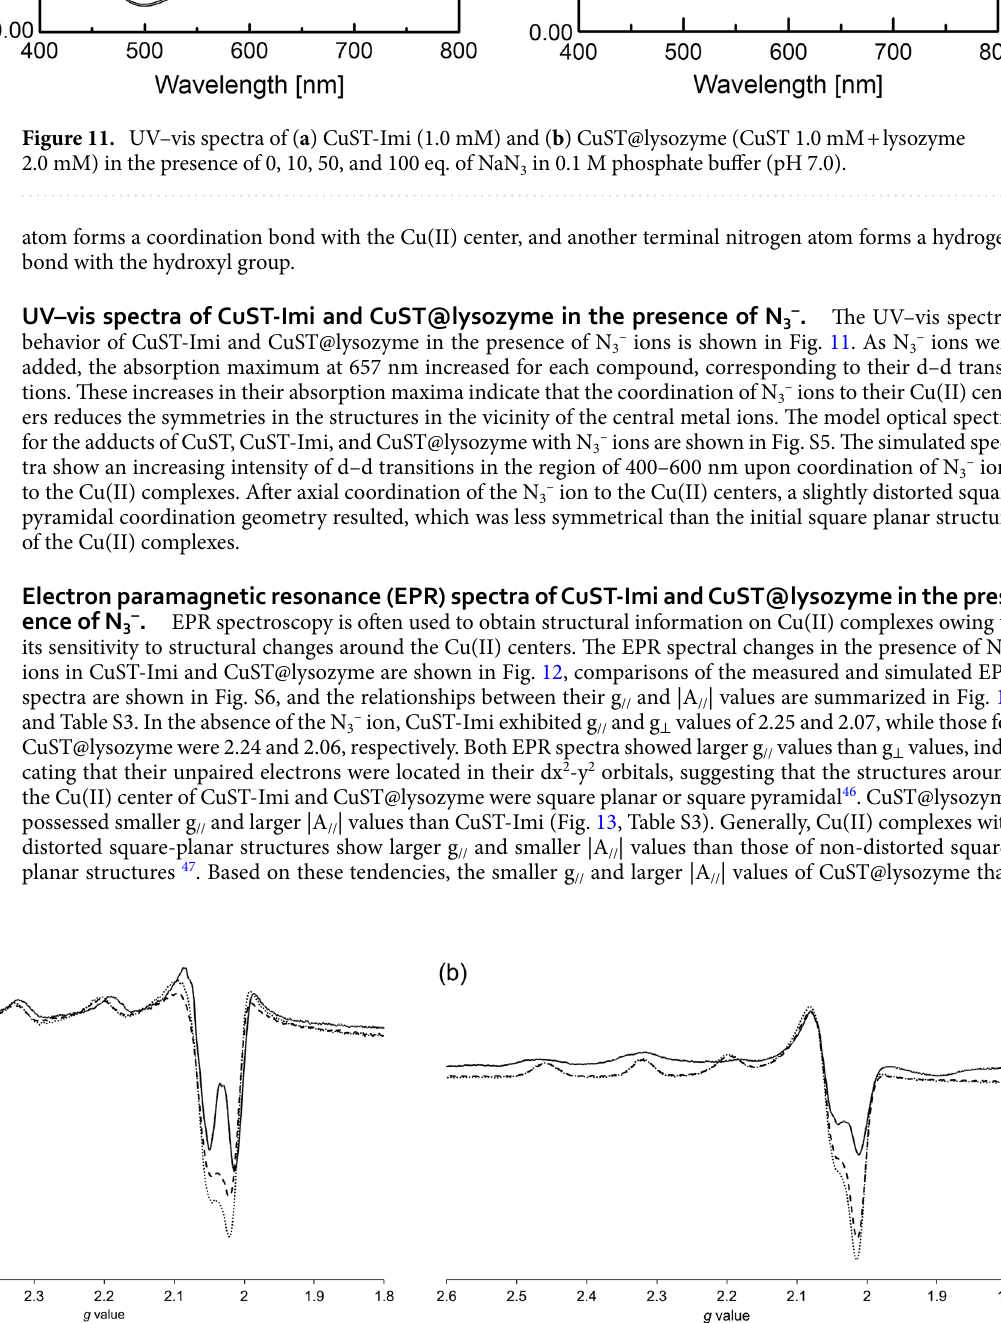
Figure 12. EPR spectra of ( a ) CuST-Imi and ( b ) CuST@lysozyme in the presence of NaN 3 . The bold, dashed, and dotted lines represent the spectra obtained in the absence of NaN 3 , in the presence of 50 eq. of NaN 3 , and